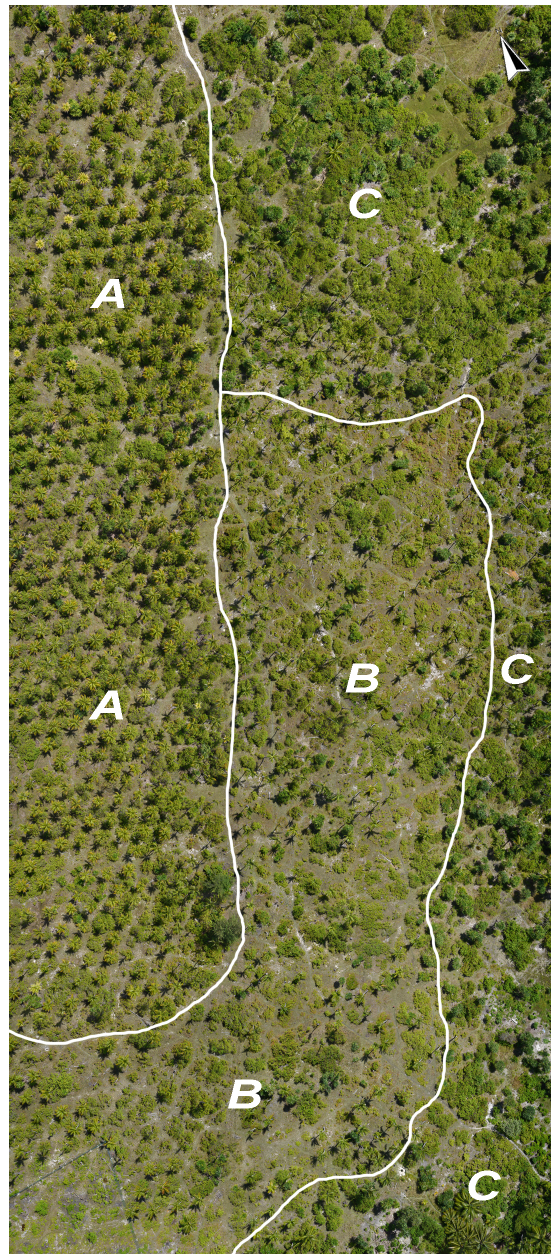
Figure 1: Orthophoto of the study site with a schematical rep- resentation of the different compositions. A: Densely grow- ing palms, B: Scattered and senile palms, C: Scattered palms and abundant presence of shrubs and trees. The Orthophoto was generated from the 100m nadir-images site (centered at Lat 1.367812, Long.